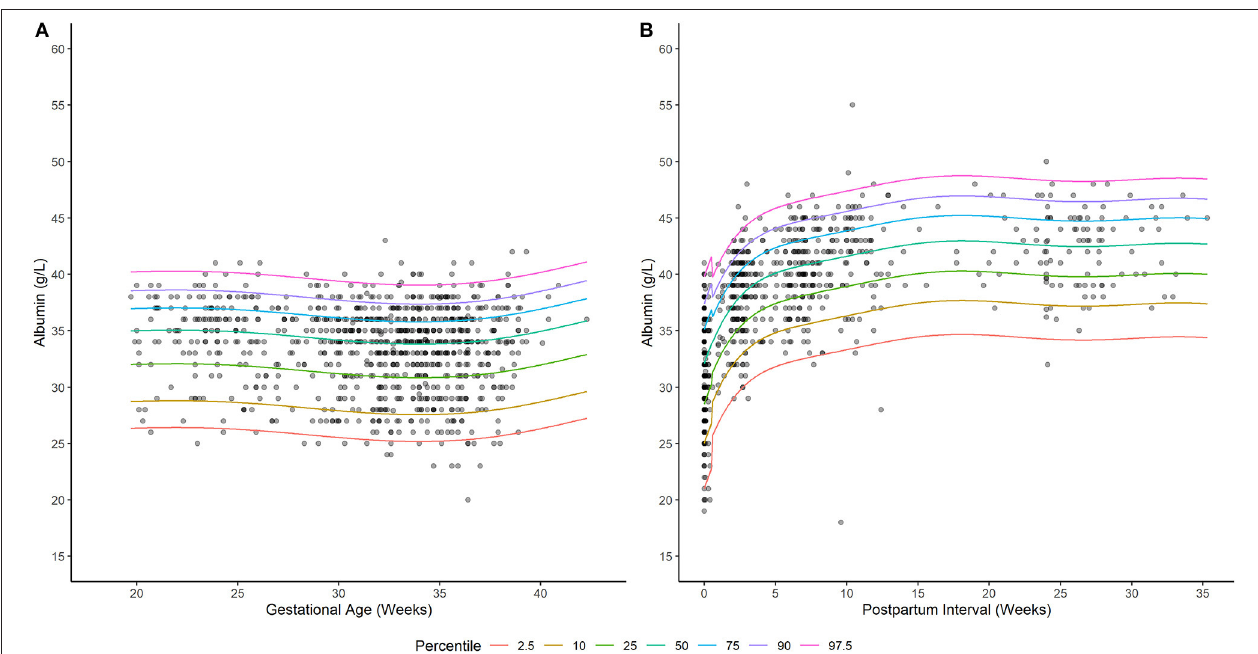
FIGURE 1 | Serum albumin concentrations in (A) pregnant and (B) postpartum women living with HIV. Solid lines depict model-based quantile estimates at denoted percentiles. Filled-circles depict observed serum albumin concentrations.